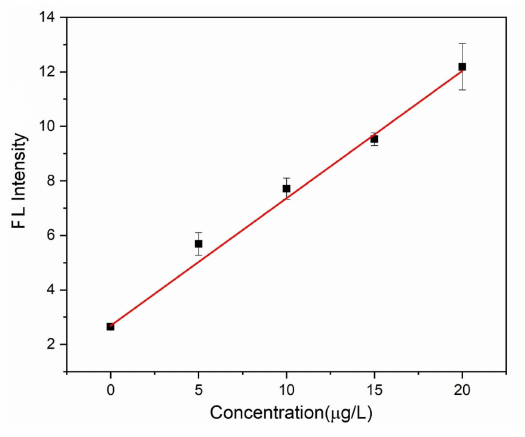
Figure 9. The fluorescence (FL) intensity as a function of the concentration of Hg 2 + . Table 2. Analytical performance of the disc for the detection of Hg 2 + .